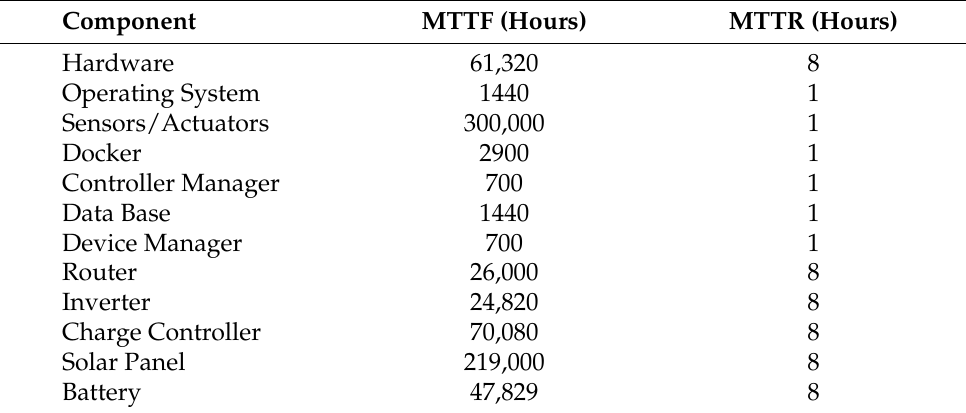
Table 3. Input values for SPN.